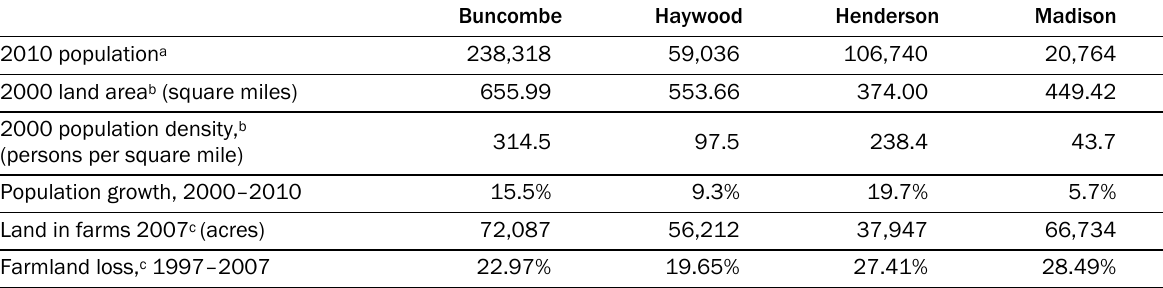
Table 1. Population and Farmland Statistics for Farmland Values Project Study